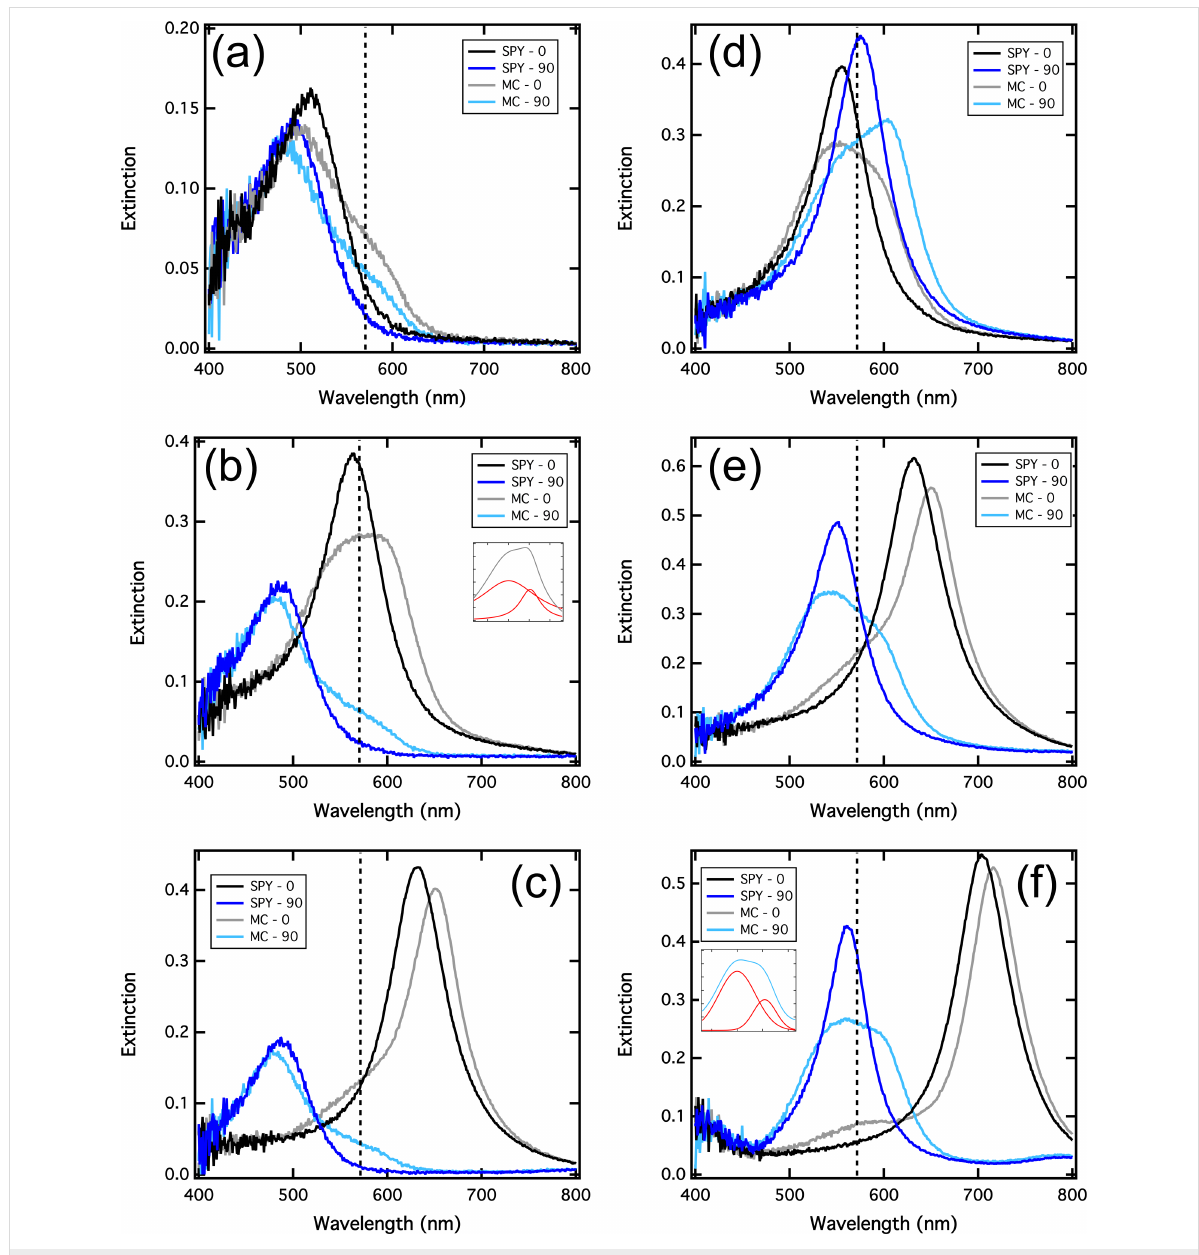
Figure 2: Extinction spectra of the silver nanorod arrays covered with photochromic molecules before (in SPY) and after (in MC) the photochromic transition. The 0° and 90° polarization orientations, corresponding to the excitation of the long and the short axis, are in black/grey and in dark/light blue, respectively. (a), (b) and (c) are measurements on nanorods presenting a width of 70 nm and lengths of 70, 90 and 110 nm, respectively. (d), (e) and (f) are measurements on nanorods presenting a width of 90 nm and lengths of 90, 110 and 130 nm, respectively.